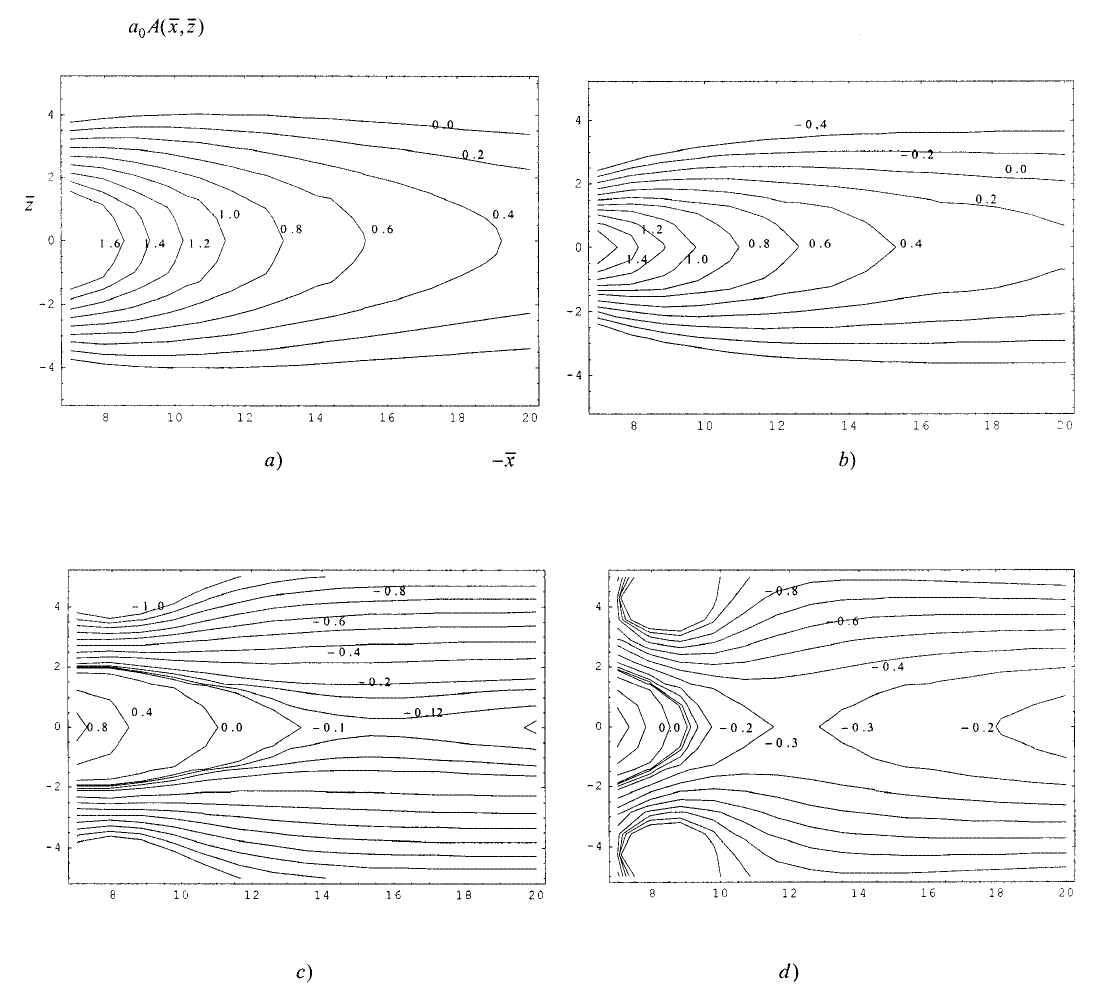
Fig. 5. Isolines of the dimensionless vector potential a 0 A(x,z) = γ 0 of parameter a = 2 m/R E B ∞ , and the value of parameter γ (13) as at Fig. 3a. Number of the curves corresponds to the value of vector potential a 0 A(x,z)